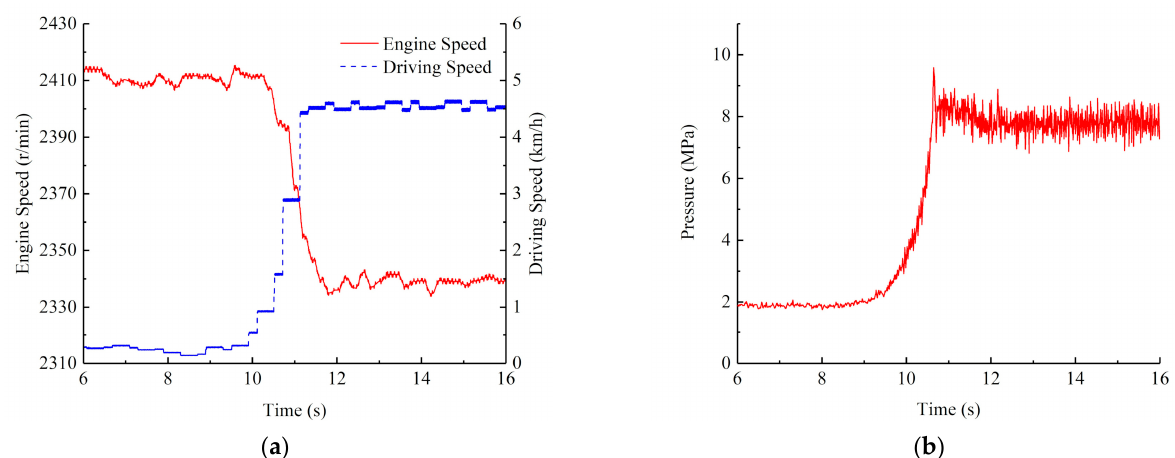
Figure 13. Parameters when starting on slope in Gear I: ( a ) change of the engine speed and driving speed; ( b ) change of the inlet and outlet pressure difference of the hydraulic motor.